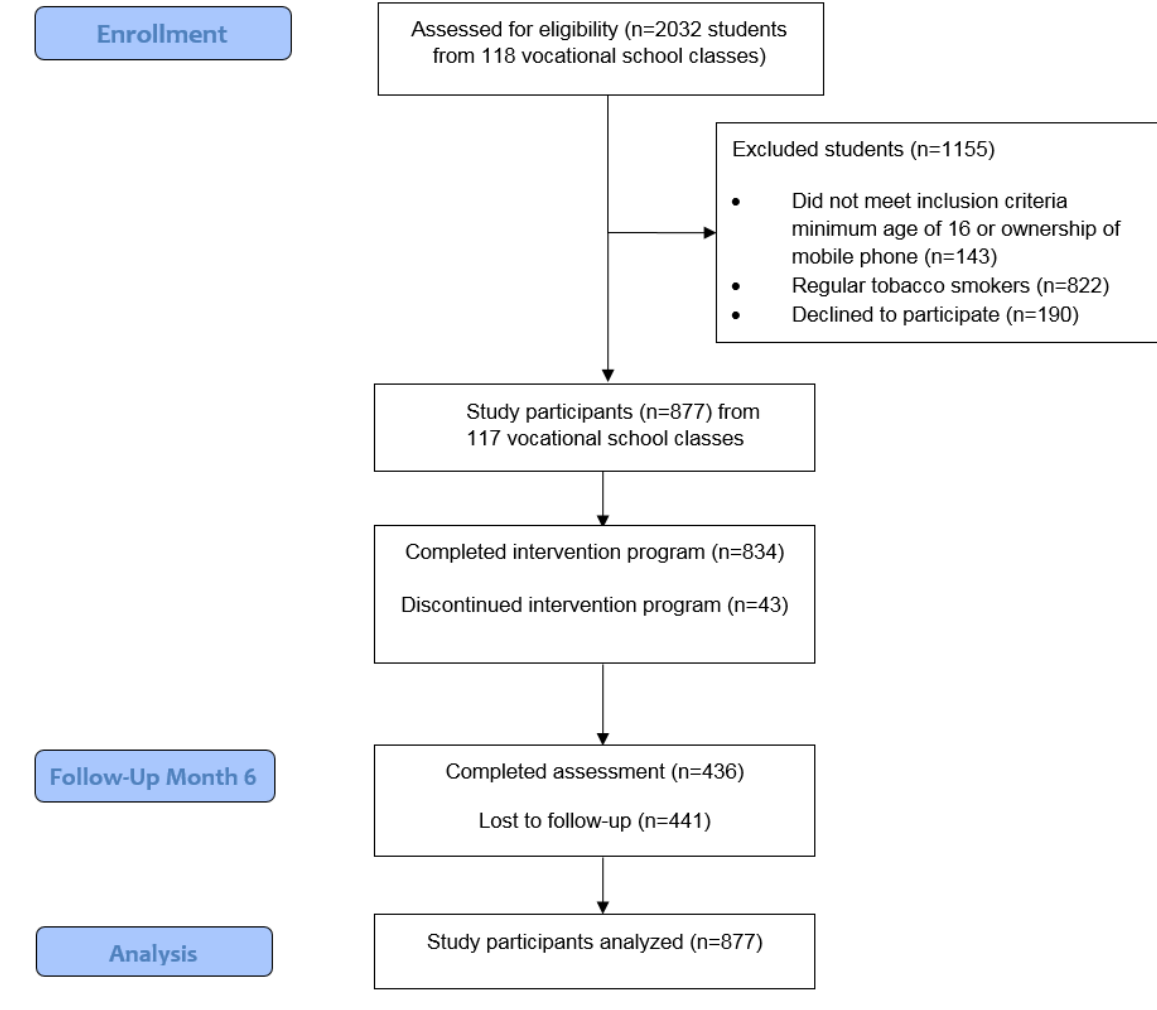
Figure 3. Participants’progress through the